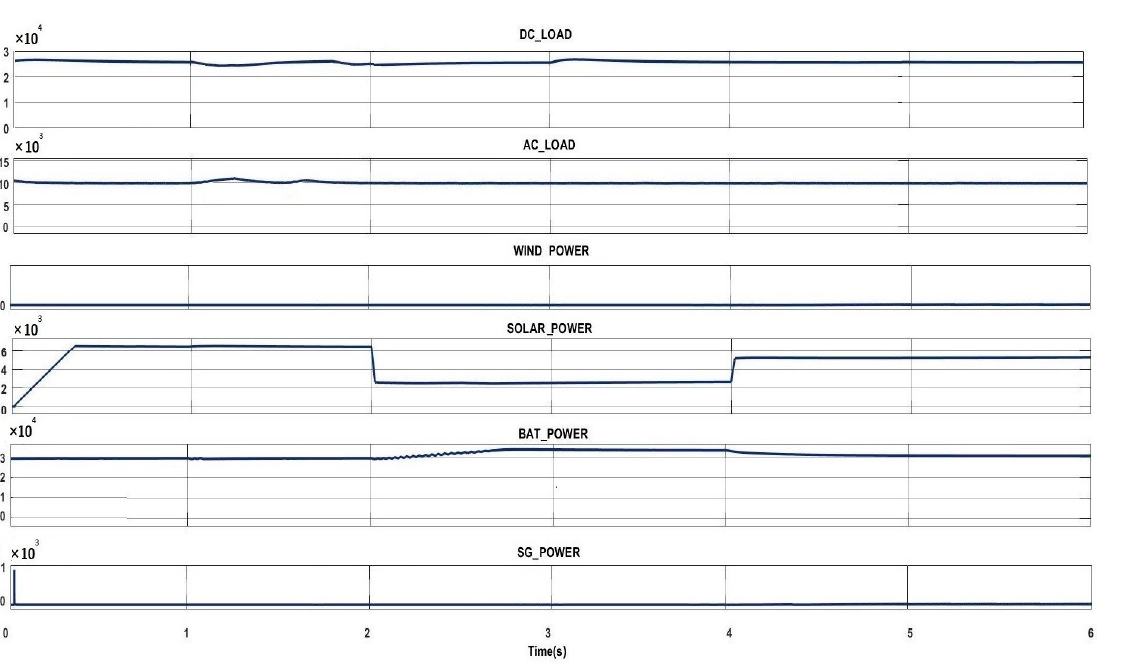
Figure 11. The common DC bus voltage for no wind speed. 6. Conclusions In this study, an overview of multi-agent-based system applications in microgrids is presented. Agent theory, multi-agent systems and concepts that facilitate microgrid oper- ation and control are introduced, and agent interaction, coordination, and cooperation are discussed in the context of multi-agent system features. The application of multi-agent systems in microgrids for different purposes such as market operations, fault detection,